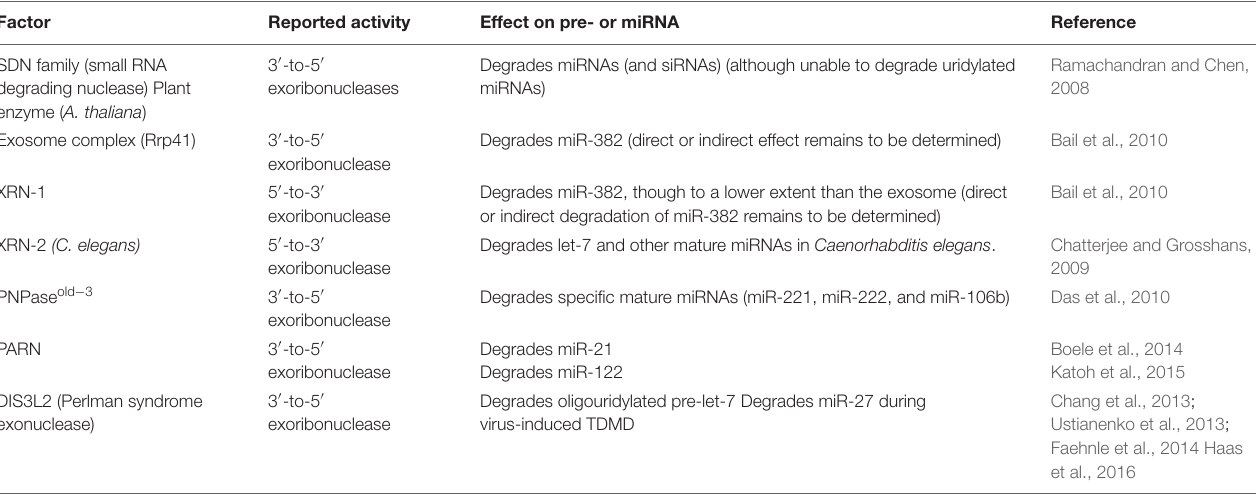
TABLE 2 | Nucleases involved in miRNA degradation.